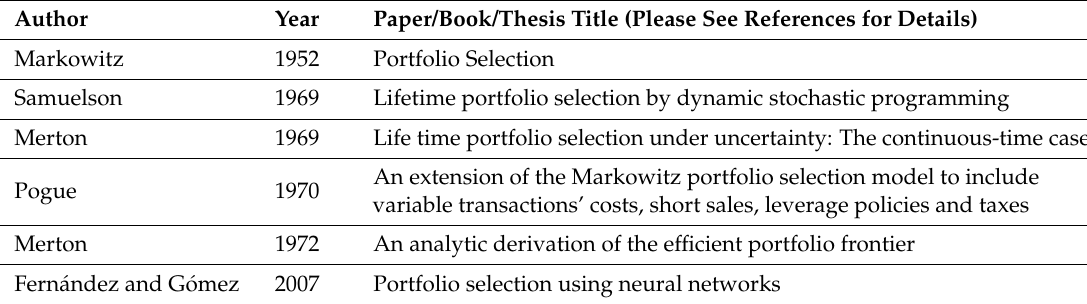
Table 2. Selected works on Portfolio